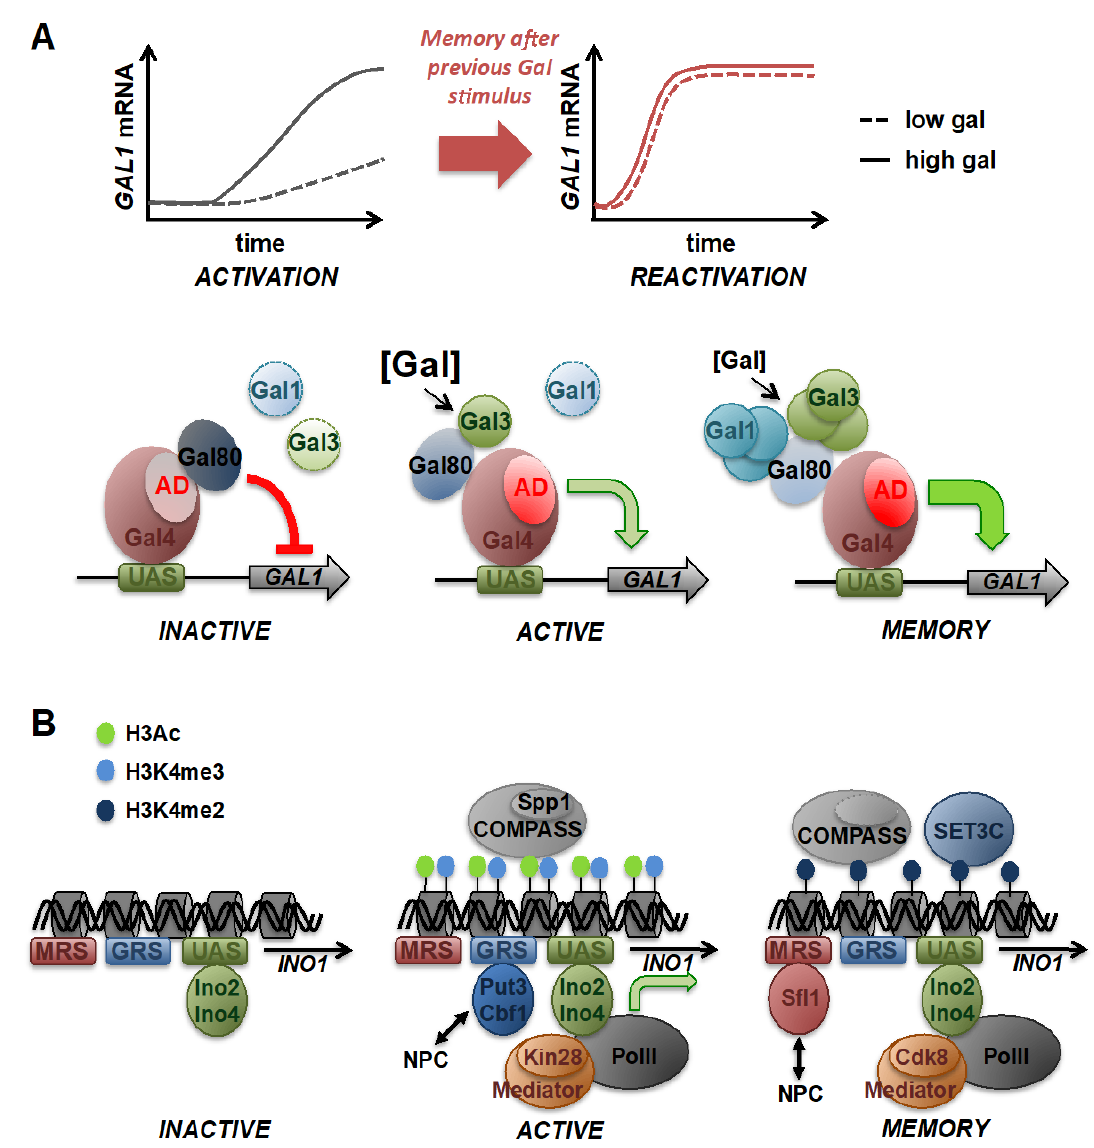
Figure 3. Mechanisms of transcriptional memory. ( A ) Trans mechanisms of improved reactivation at the GAL1 gene after repeated galactose stimulation. Upper panel: Naïve cells exhibit slow and galactose-insensitive GAL1 activation kinetics. After a previous encounter with galactose, cells respond with a faster, more efficient and sensitive gene induction. Lower panel: Details of transcriptional memory at GAL1 by the reinforcement of signaling. The inactive GAL1 gene is bound by the Gal4 transcriptional activator, which is completely inactivated by association with the Gal80 repressor masking the Gal4 activation domain (AD). A first round of GAL1 transcriptional activation (active) is slow and inefficient due to the low amount of the Gal3 galactose sensor and signal transducer. After memory, the previously induced and inherited Gal1 and Gal3 proteins prepare the experienced cells for fast reactivation even at low galactose doses. Both Gal1 and Gal3 can induce GAL1 expression by Gal80 inhibition. ( B ) Epigenetic mechanisms of memory at the INO1 gene after repeated inositol starvation. The inactive INO1 gene is characterized by absent histone acetylation or